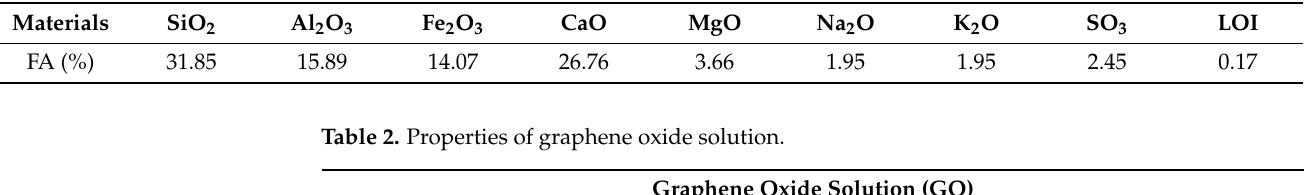
Table 1. Chemical compositions of fly ash.